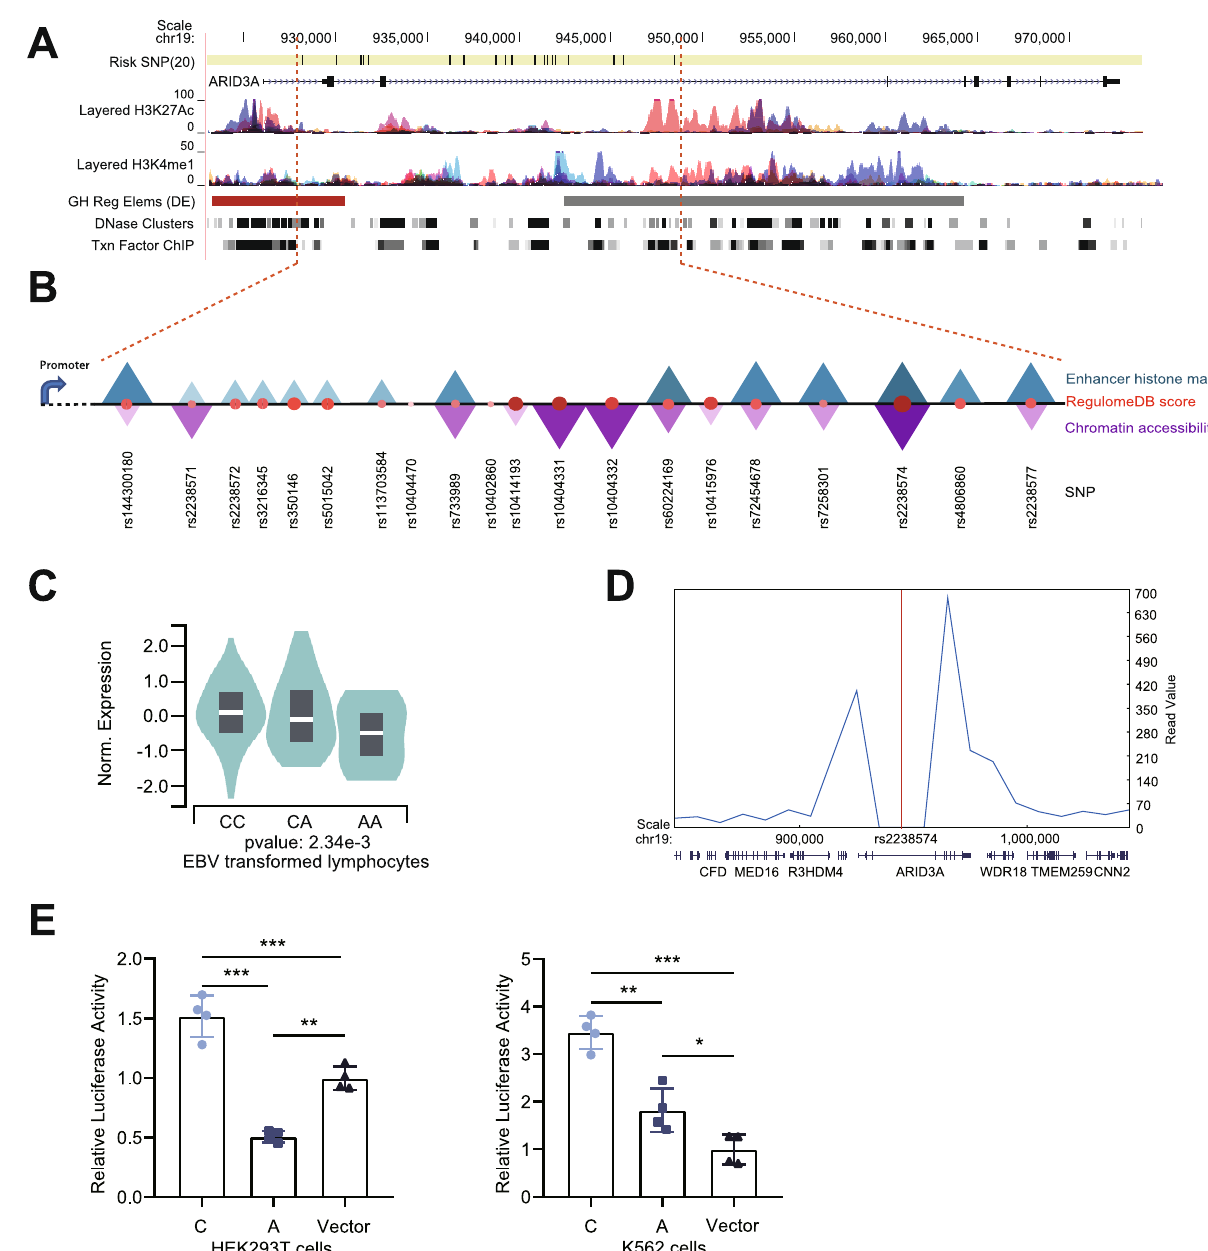
Fig. 2 | Rs2238574 is a putative regulator of ARID3A expression. A UCSC GenomeBrowserviewsofchromatinstateof19p13.3. B Annotationof20candidate variants, the size and color of the triangle and/or circle is proportional to annota- tiondata. C Associationbetweenrs2238574genotypesandexpressionof ARID3A in EBV-transformed lymphocytes (CC, n =30; CA, n =80; AA, n =37). Source data are derived from GTEx. D Three-dimensional chromatin interactions for the ARID3A